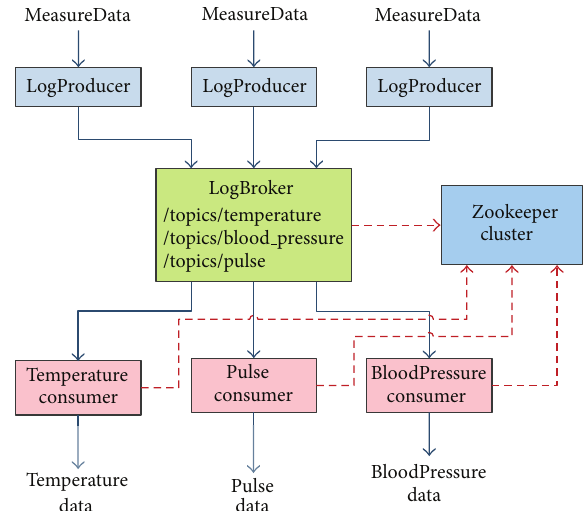
design pattern, when a new rule is introduced in the system, the latter does not need to be recompiled. This ensures loose-coupling of the